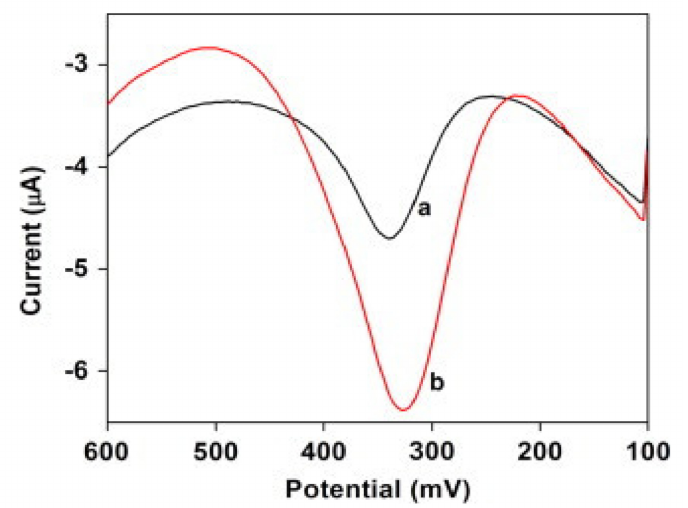
Figure 8. Comparison between square-wave voltammograms (SWVs) obtained with (a) unmodified edge plane pyrolytic graphite (EPPGS) sensor and (b) polymelamine modified EPPGS sensor in 20 µ M serotonin solution (electrolyte was PBS at pH 7.2). Reprinted from [112] with permission of